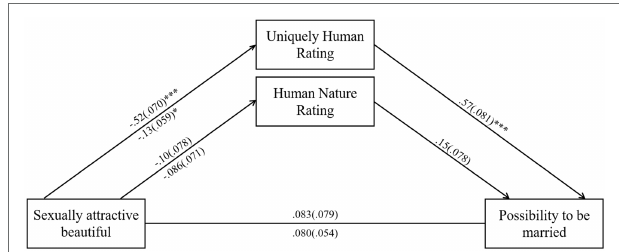
FIGURE 1 | Path estimates for the mediation effect of the “sexually attractive” woman and “beautiful” woman image prime on the possibility of being married through human nature and uniquely human rantings. For paths at the first stage of the model, values above the line reflect estimates for the “sexually attractive” woman image, relative to the control. Values below the line reflect estimates for the “beautiful” woman image, relative to the control (coded 0 = virtuous woman; 1 = comparison). Also, * p < 0.05; ** p < 0.01; and *** p <